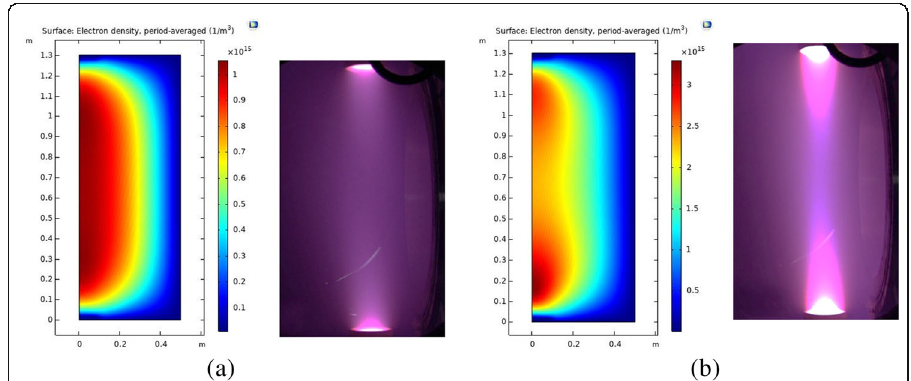
Fig. 5 Simulated electron densities and images taken by a camera under 6 Pa environmental pressure, with electric excitation power of ( a ) 3.0 kW, and ( b ) 9.5